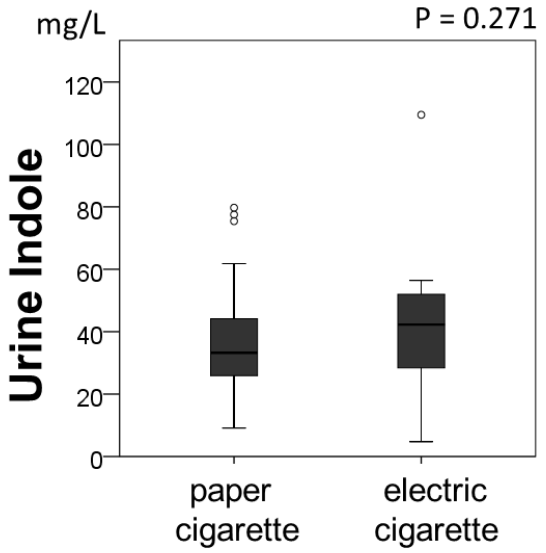
Figure 3. Comparison of the types of cigarettes in urine indole levels for current-smokers. The p -value on the graph indicates that there is no significant difference among the groups ( p = 0.271).